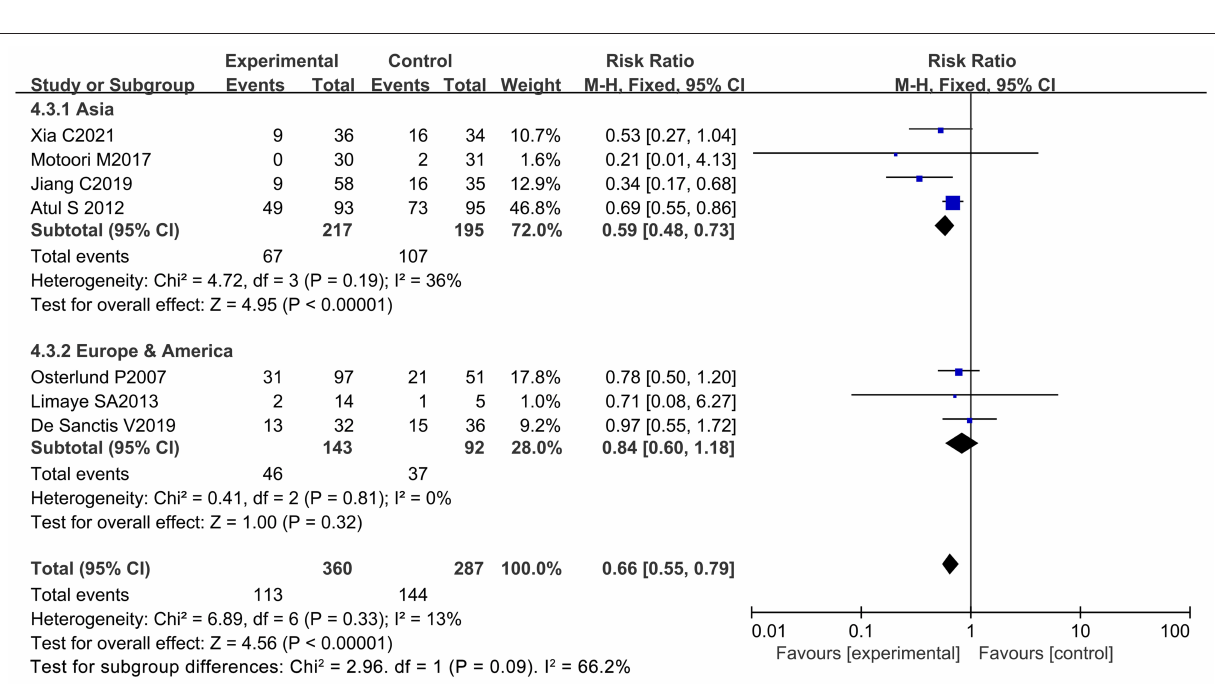
FIGURE 9 | Subgroup analysis of the efficacy of oral probiotic use against severe oral mucositis in cancer patients based on continental region.